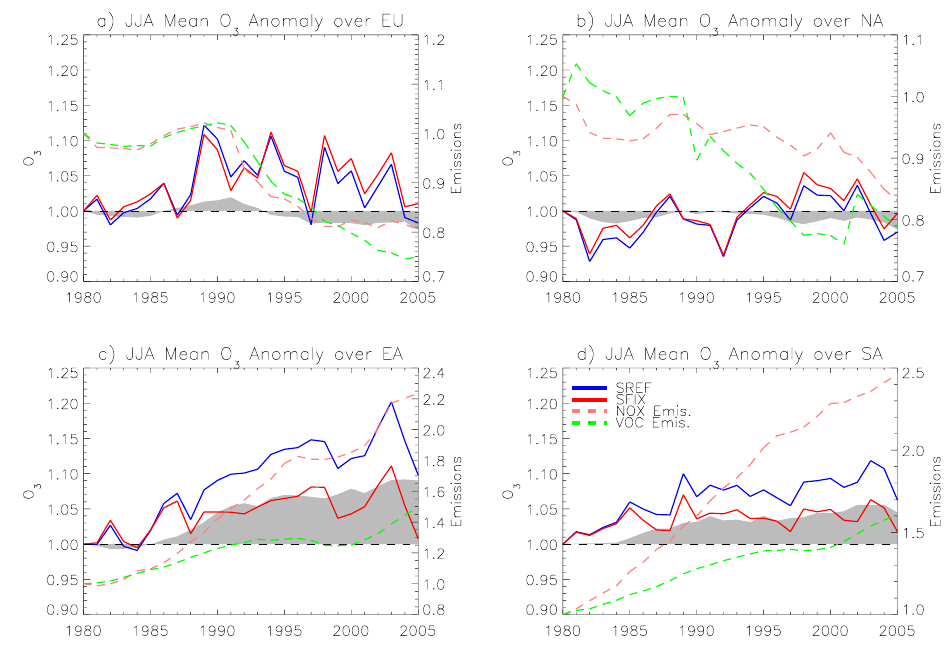
Fig. 8. As Fig. 7 for summer (JJA) anomalies of surface O 3 concentrations.